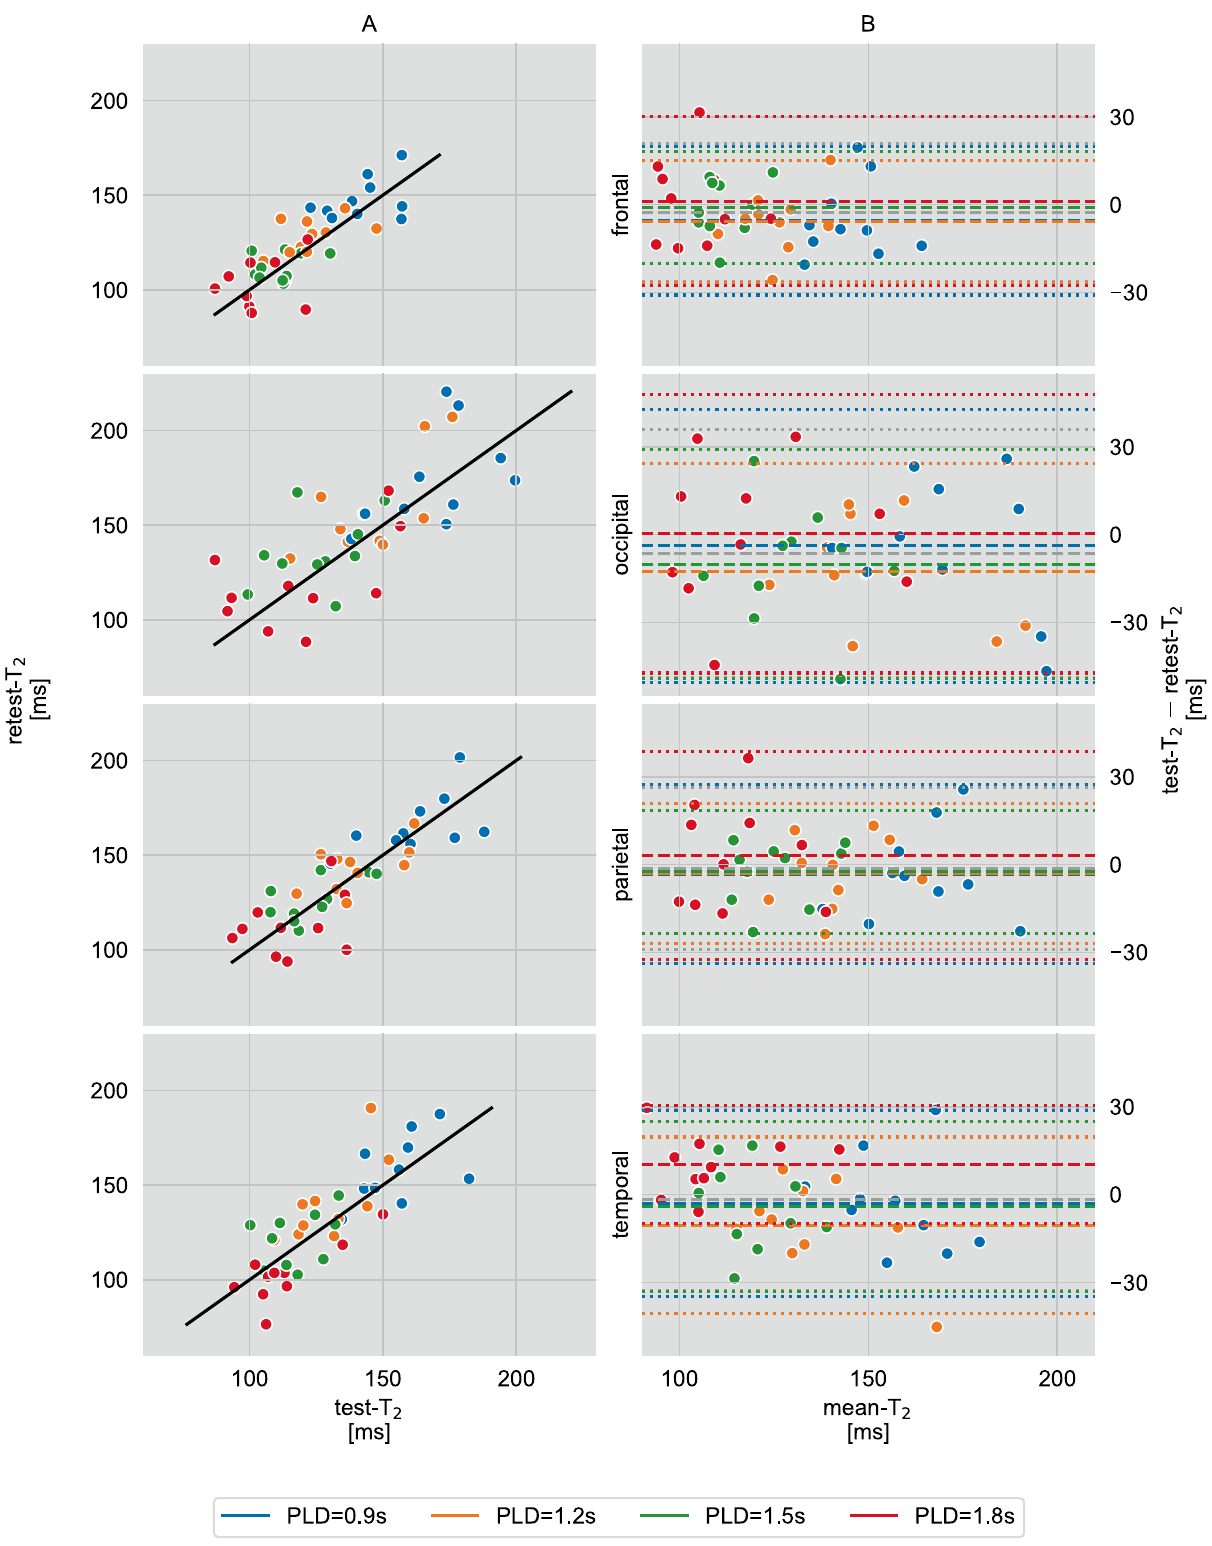
Figure 3. ( A ) Correlation of median T 2 values from repeated measurements of ten subjects in four gray matter regions of interest (ROIs) at four postlabeling delays PLD = 0.9/1.2/1.5/1.8 s. The solid line is the identity function and represents optimal correlation. ( B ) Agreement (Bland–Altman plot) between test and retest T 2 values which are shown in ( A ). The mean differences between both scans at each PLD are represented by the dashed lines and dotted lines display the corresponding limits of agreement ( 1.96 × standard deviations of mean